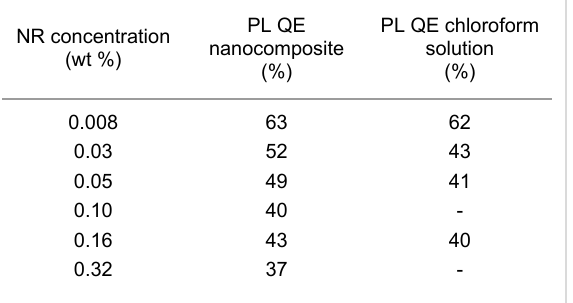
NR concentration (wt %)